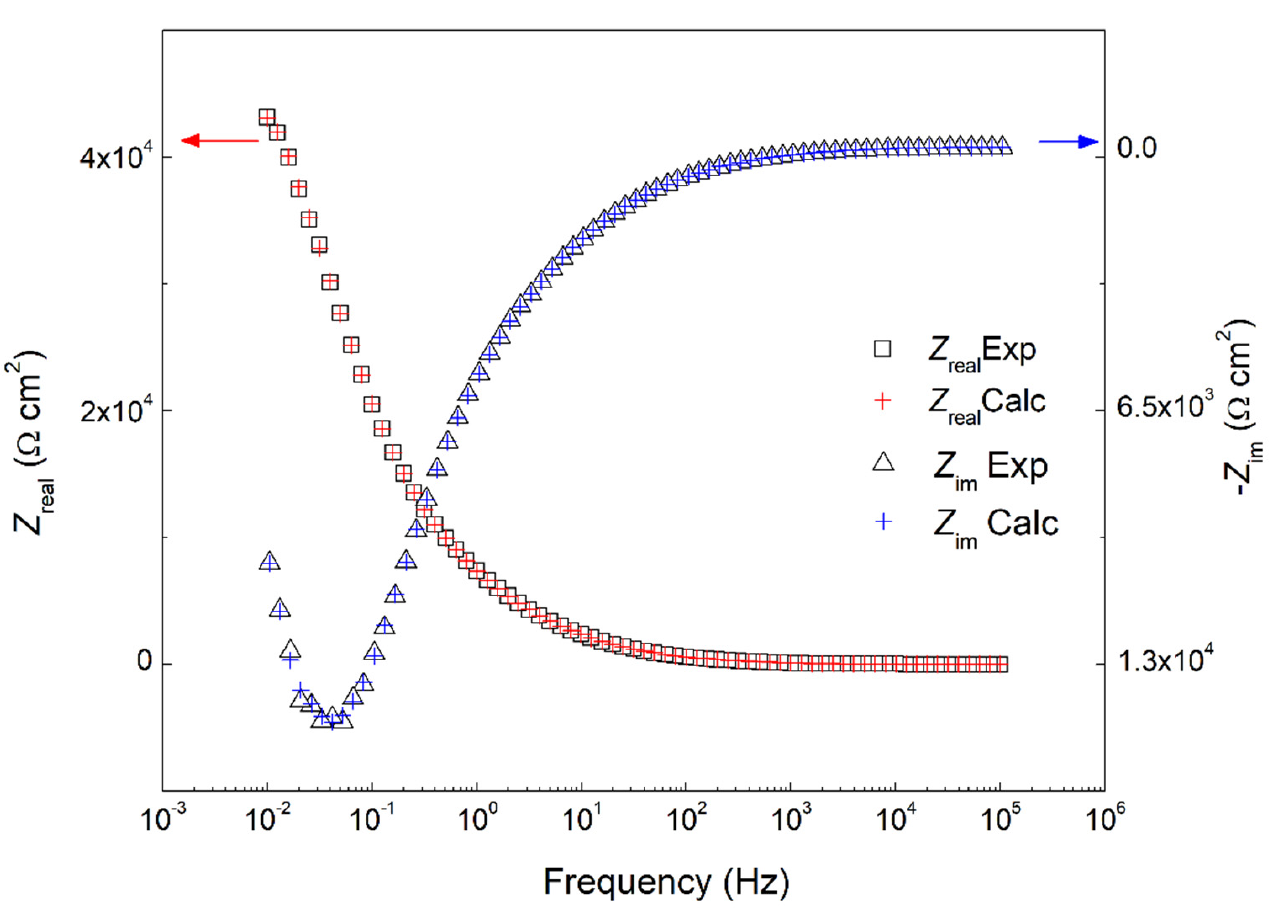
Figure 4. Experimental EIS data of 0.6 M sodium succinate inhibited carbon steel in 0.6 M Cl − SCPS, and calculated values using Kramers–Kronig (KK) transformation at 25 °C.